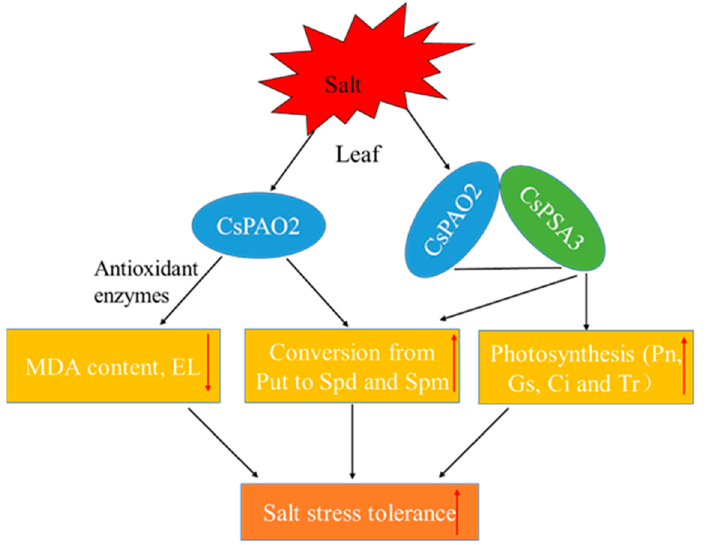
Figure 7. A proposed model of CsPAO2 enhancing salinity stress tolerance of cucumber through interaction with CsPSA3. Red arrows pointing up or down represent increase or decrease. interaction with CsPSA3. Red arrows pointing up or down represent increase or